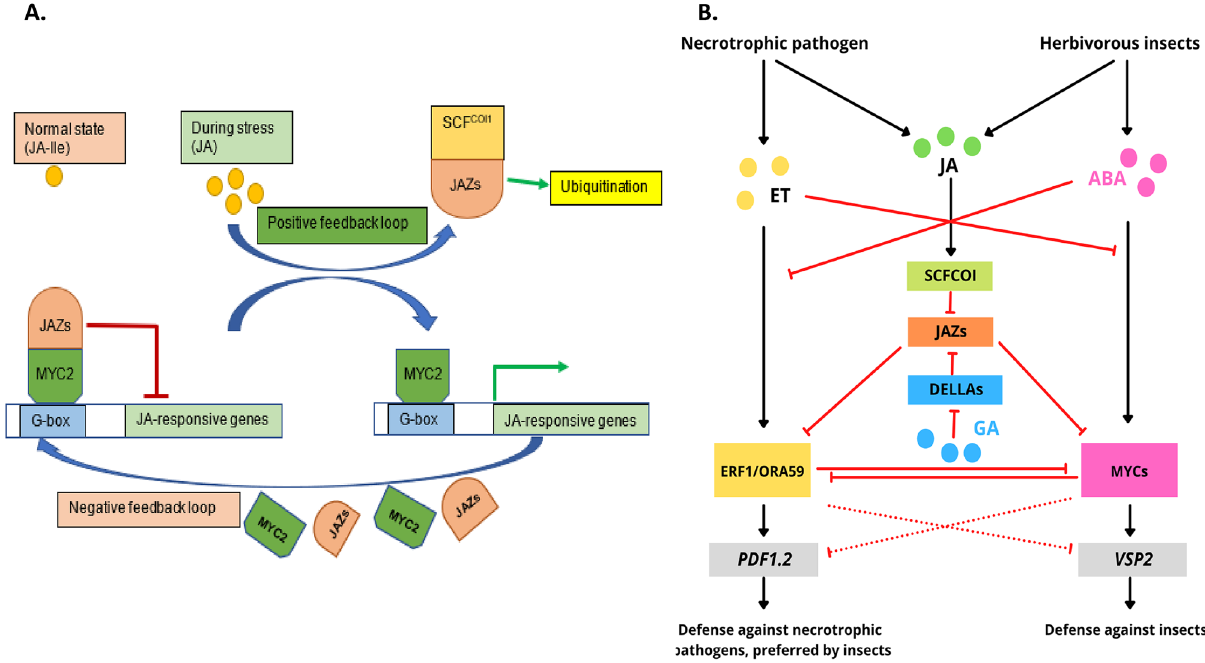
Figure 1. Proposed model for JA perception via COI1-JAZ co-receptor complex ( A ) and crosstalk between phytohormones in the defense signaling pathway ( B ) (adapted from Wasternack and Hause 2 ; Pieterse et al. 13 ). ( A ) During stress and wounding JAZ are recruited by the SCF COI1 and MYC2 are released thus activating JA-defense genes (positive feedback loop). The newly synthesized JAZ genes during defense response binds to the MYC2 thus repressing the JA-defense genes (negative feedback loop). ( B ) Herbivorous insects induce JA- and ABA-dependent signaling pathways while necrotrophic pathogens induce JA- and ET-dependent signaling pathways. Solid lines are established interactions, dashed lines are hypothesized interactions, arrows indicate positive effects, and red inhibition lines represent negative effects. JA, Jasmonic acid; JAZ , JASMONATE ZIM DOMAIN ; SCF COI1 , SCF-type E3 ubiquitin ligase; MYC2 , bHLHzip transcription factor MYC2; ERF1, Ethylene Response Factor 1 ; ORA59, octadecanoid-responsive Arabidopsis AP2/ERF-domain protein 59 ; VSP2, VEGETATIVE STORAGE PROTEIN2 ; PDF1.2, PLANT